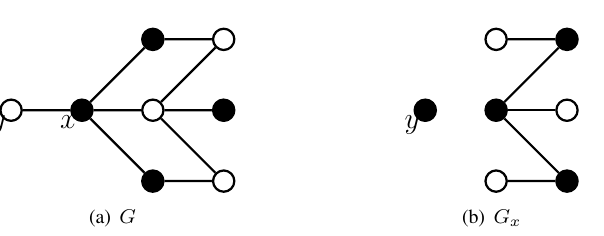
Fig. 5: The bipartite graph of order 8 with three AB ′ α 3 -pairs. It is possible that there are more edges between y and the other vertices. The black dots represent an identifying